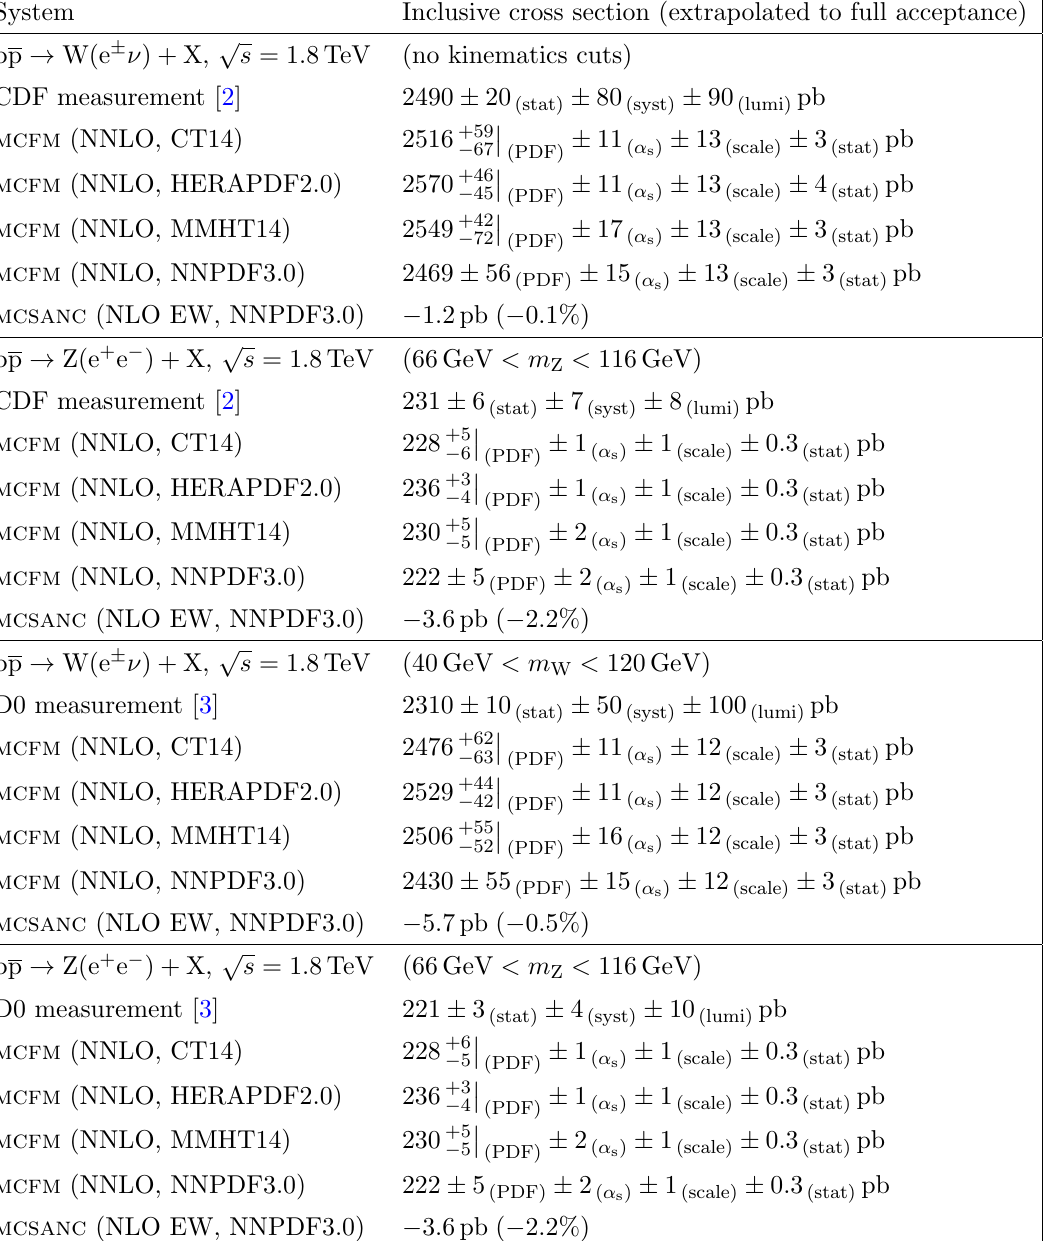
Table 9 . Comparison of the CDF and D0 inclusive cross sections for W (cid:6) and Z boson production p in pp collisions at s = 1 : 8 TeV to the NNLO pQCD results obtained with mcfm using the CT14, HERAPDF2.0, MMHT14, and NNPDF3.0 PDF sets, including NLO EW corrections computed with mcsanc (also listed independently in the last